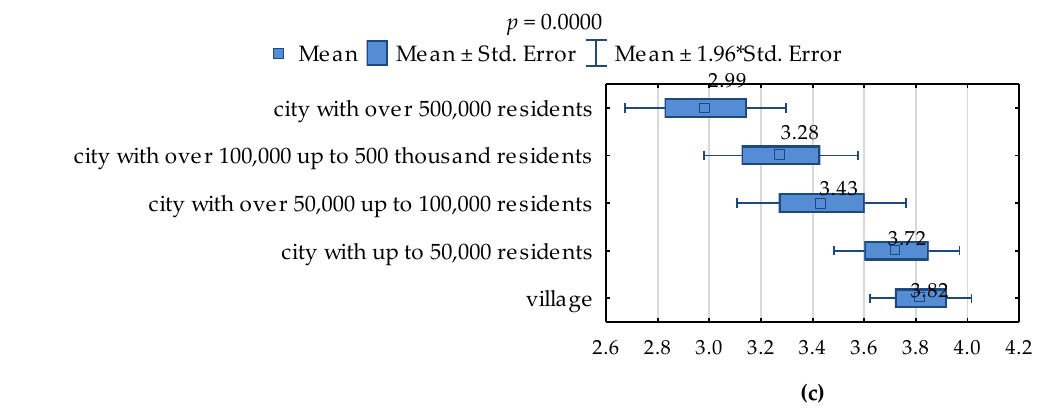
Figure 5. Average ratings of concerns related to the energy crisis: ( a ) the problem of purchasing raw materials for heating due to the apartment building; ( b ) the problem of not being able to meet household energy needs due to the apartment building; ( c ) the problem of purchasing raw materials for heating due to the place of residence. Source: own elaboration.